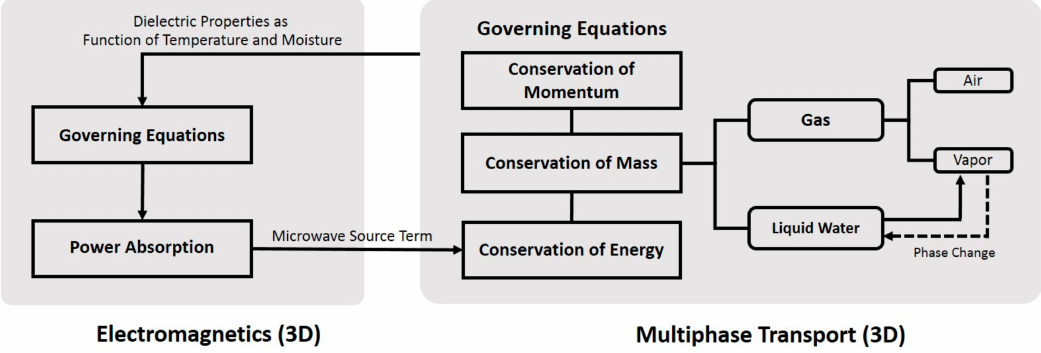
Figure 5. Flow chart of the sequence of steps followed to develop the computational